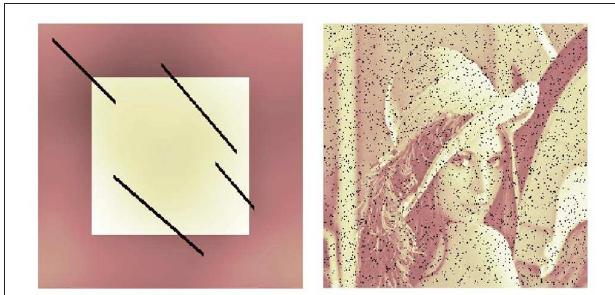
FIGURE 3 | Considered inpainting area types: Scratches (Left) and randomly missing pixels (Right)